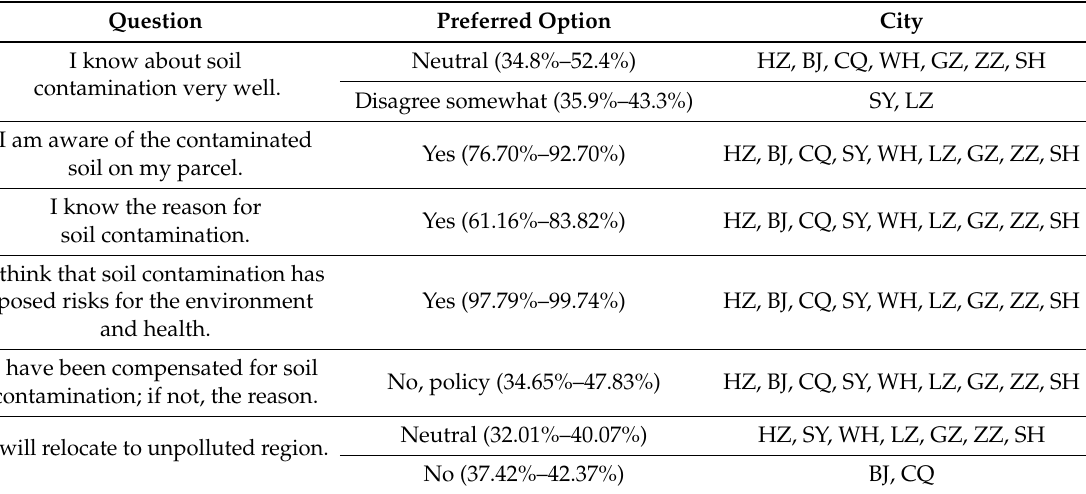
Table 3. Residents’ perception on soil